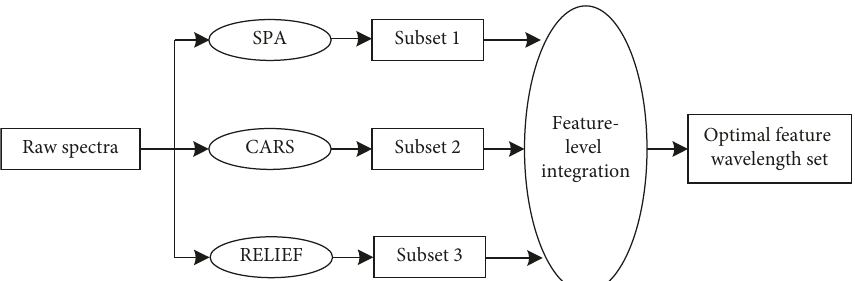
Figure 2: The feature-level integration-based wavelength selection method.